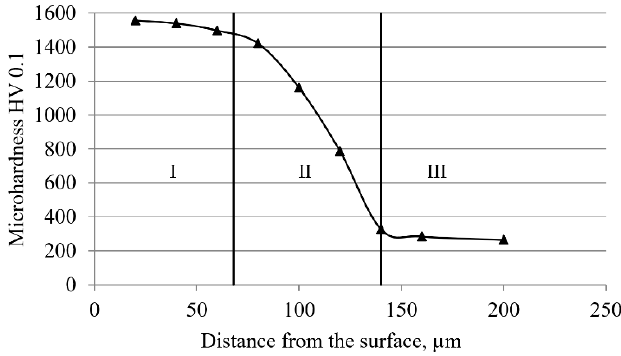
Figure 9. Cross-sectional hardness change of the sample boronized at 920 °C for 6 h.